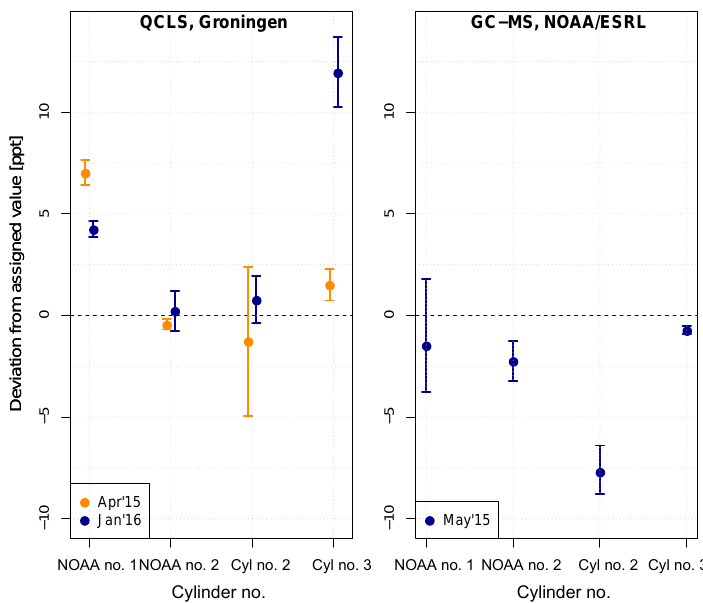
Figure 9. Flask sample measurements at the QCLS in Groningen (left) and GC-MS by NOAA/ESRL (right). Four paired flasks were filled with dry air from the two NOAA/ESRL calibration standards and two working standards, which were calibrated as in Sect. 2.2.2. The flask pair measurements are averaged and shown as the deviation from the assigned cylinder value. The first two cylinders are those calibrated at NOAA/ESRL and have an assigned value of 447.8ppt (NOAA no. 1) and 486.6ppt (NOAA no. 2). The last two cylinders were used as working standards in Lutjewad and have assigned values of 467.6ppt (no. 3) and 455.5ppt (no. 4). The error bars show the precision. For the QCLS two measurements were done: in April 2015 (orange) and in January 2016 (blue). The GC-MS measurement at NOAA/ESRL was performed in May